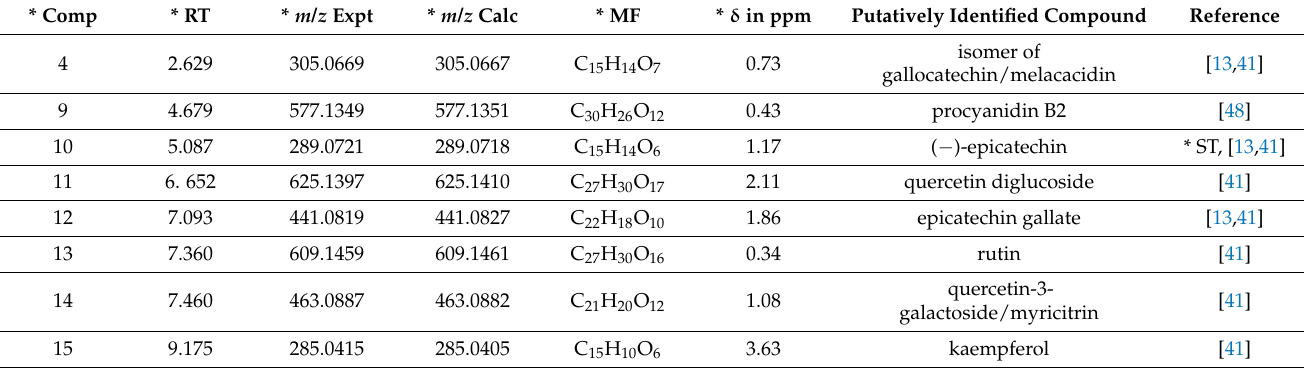
Table 3. Tentative assignment of compounds in Acacia implexa leaves (crude